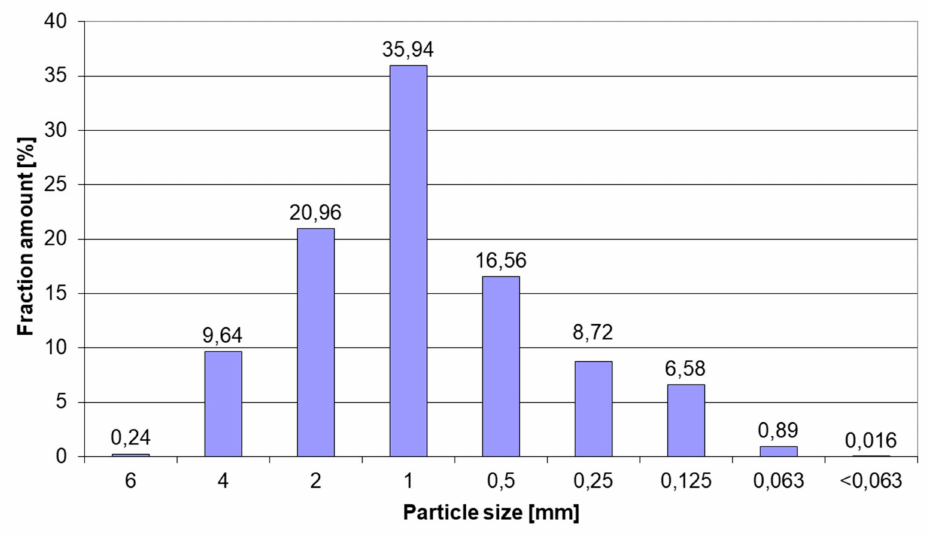
Figure 3. Particle size distribution of raw material (sawdust) used during the research. The largest percentage of the tested raw material was represented by the 1.00 mm fraction (35.94%). The 2.00 mm fraction (20.96%), the 0.50 mm fraction (16.56%), and the 4.0 mm fraction (9.64%) had slightly smaller